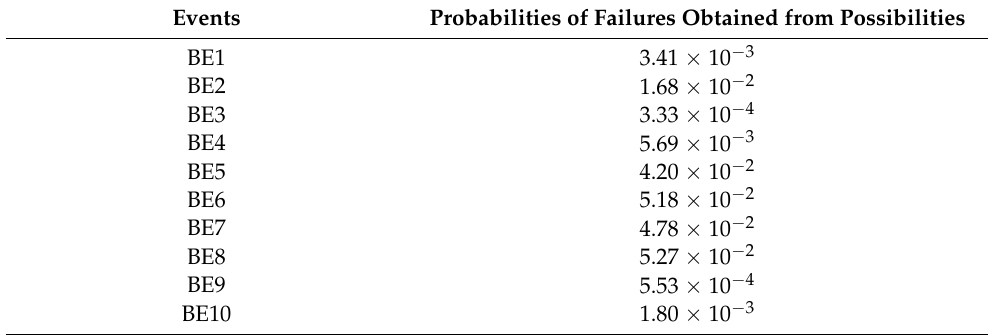
Table 10. Probabilities of each event calculated from possibilities.